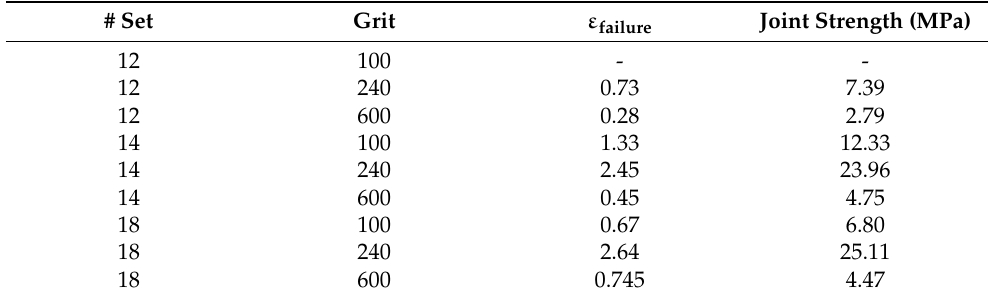
Table 5. Results from the tensile tests of samples welded with sets 12, 14 and 18—S235 galvanized steel subjected to surface mechanical pre-treatment before the welding process.